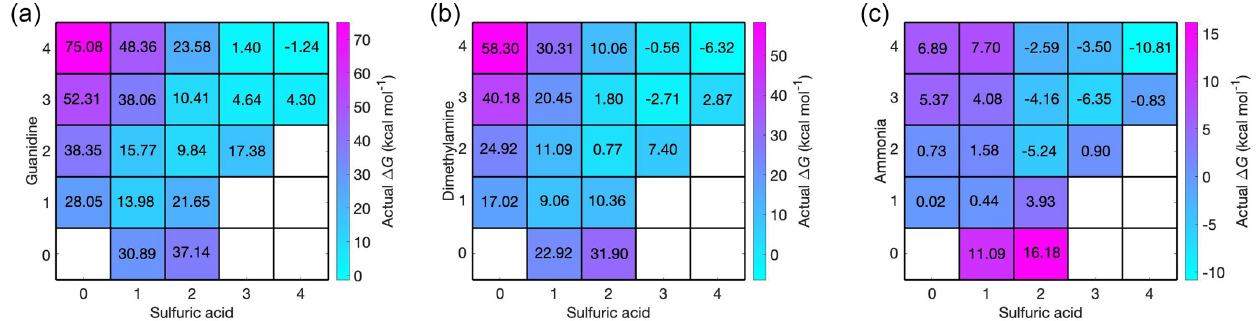
Figure 7. Concentration-dependent Gibbs free energies for protonated-base-containing acid–base clusters at 298.15K. Sulfuric acid con- centration is 10 7 cm − 3 in all cases, and for bases the relative concentrations of [guanidine] = 10 − 5 ppt V (a) , [dimethylamine] = 1ppt V (b) and [ammonia] = 10 5 ppt V (c) are used. Note that the x and y axes refer to the numbers of neutral acid and base molecules and each cluster contains one protonated base